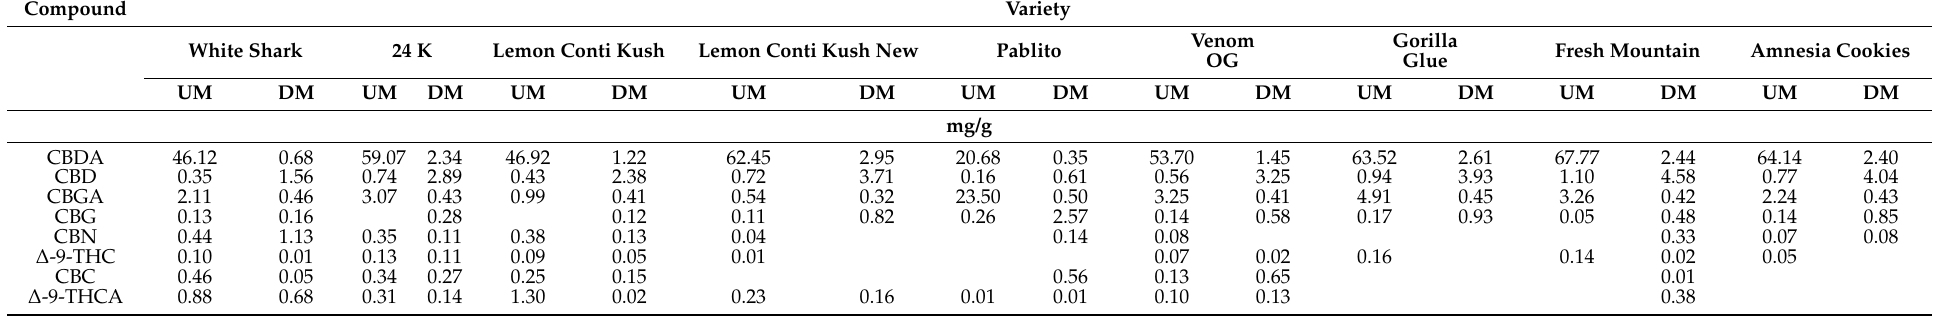
Table 9. HPLC-DAD-MS n characterization of cannabinoids in UM and